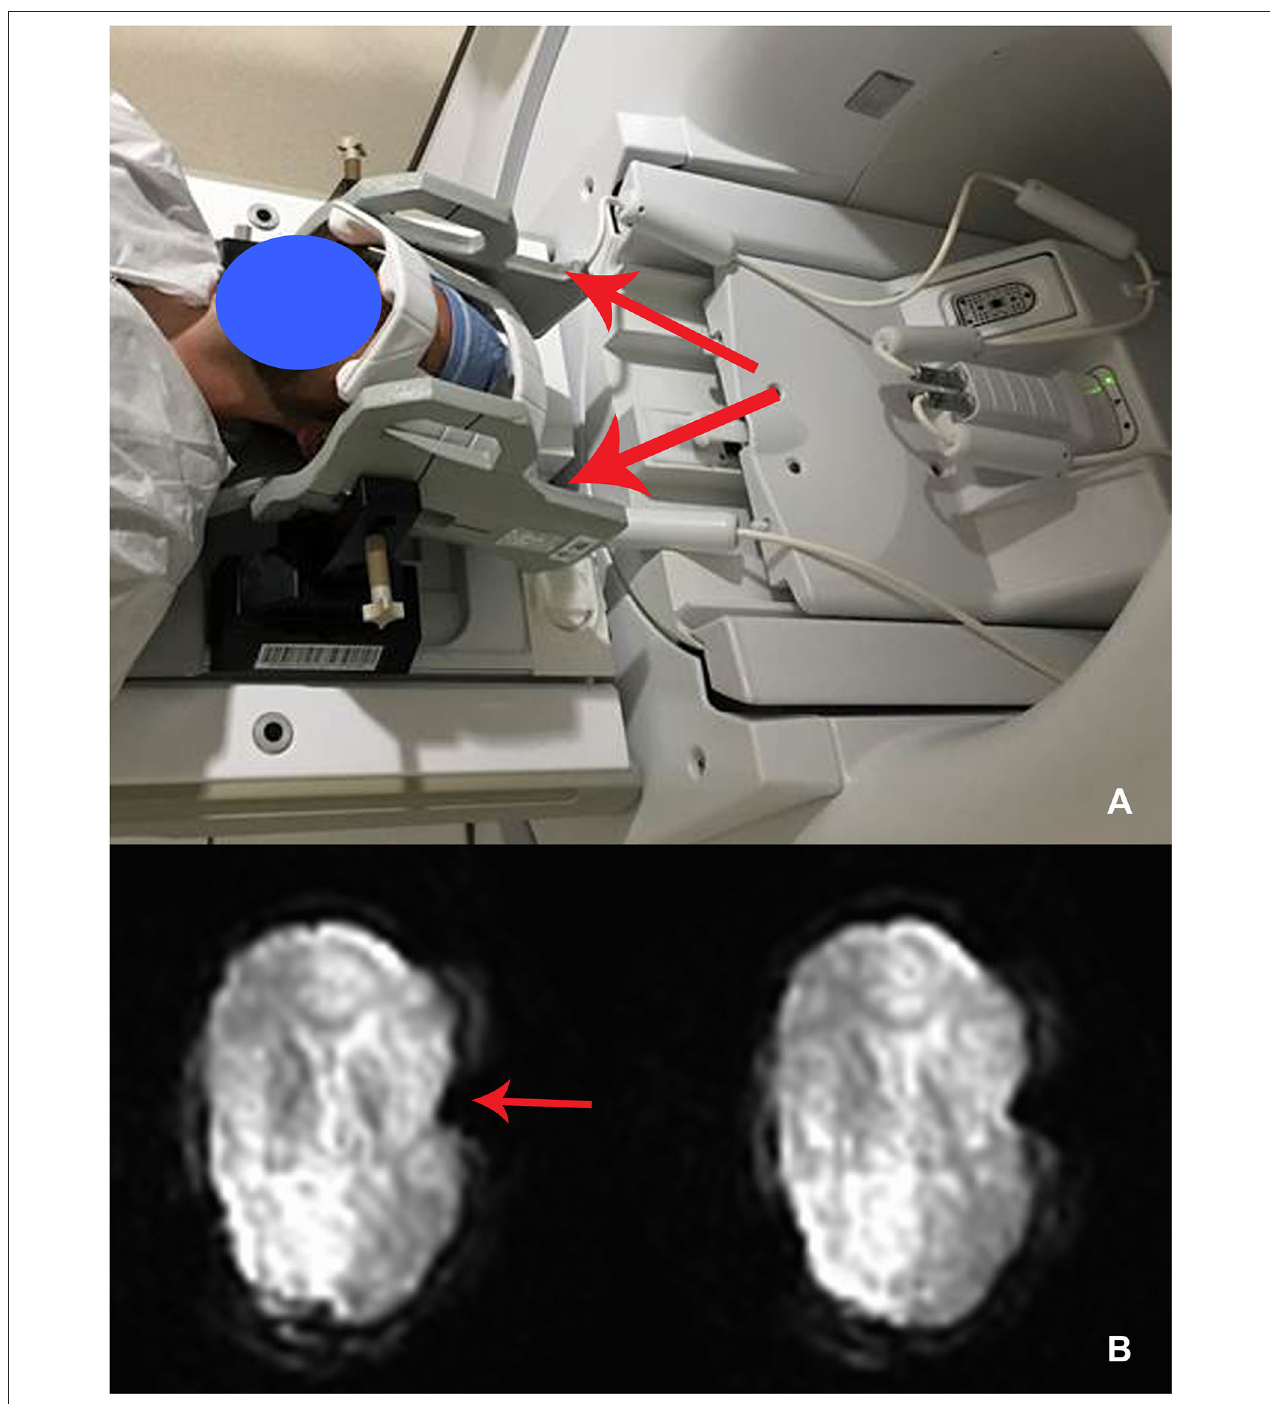
FIGURE 1 | (A) Intraoperative set up using receive-only six-channel phase array coil (two red arrows) (left). (B) EPI images with the susceptibility artifact due to the metallic pins used to immobilize the head (arrow) (right).